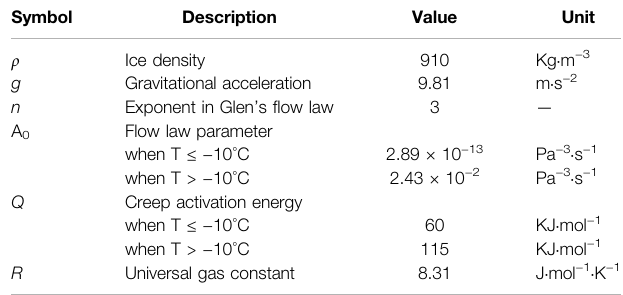
TABLE 3 | The parameters of the ice- fl ow